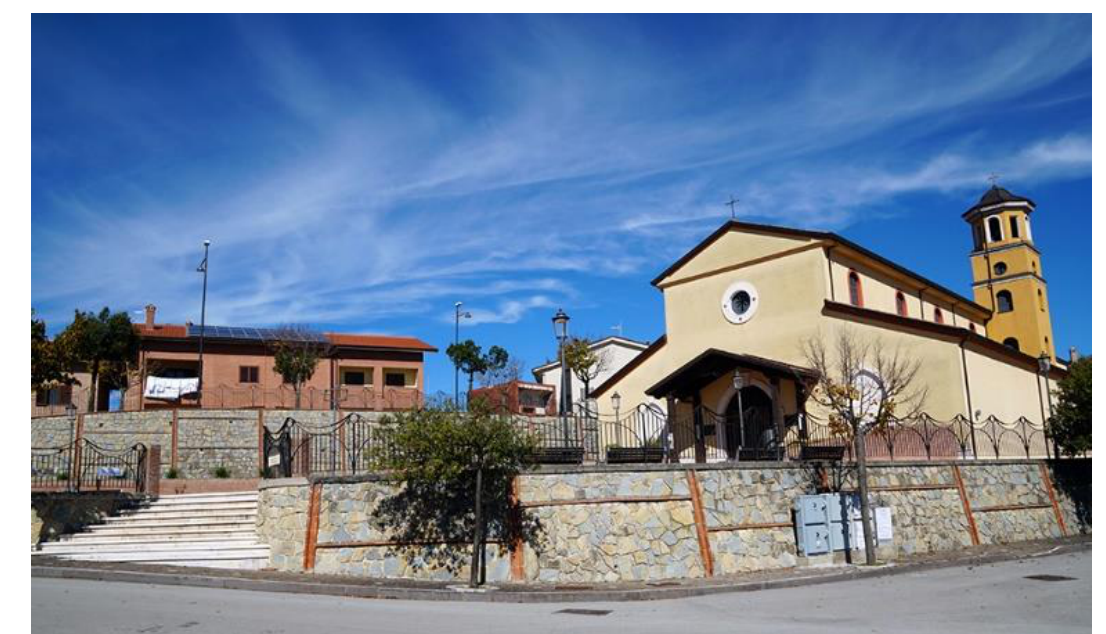
Figure 87. Romagnano al Monte: details of the old village completely abandoned after 1980 earthquake, (photos by [35,36]).